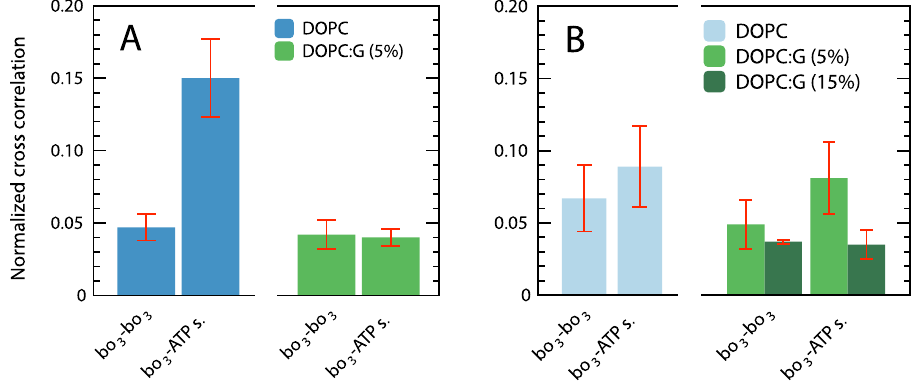
Figure 5. Summary of normalized cross correlation amplitudes measured with GUVs with co-reconstituted cyt. bo 3 and ATP synthase. ( A ) The normalized amplitudes were calculated from samples with cyt. bo 3 labeled with either ATTO 647 N or ATTO 594 ( bo 3 - bo 3 ), and cyt. bo 3 labeled with ATTO 647N and ATP-synthase labeled with ATTO 594 ( bo 3 -ATP s.). ( B ) Cyt. bo 3 was labeled with Abberior STAR 635. The lipid composition was either 99% DOPC (DOPC, blue) or 84–94% DOPC and 5–15% DOPG (DOPC:G, green), and in addition 1% DPPE functionalized with a biotinyl head group. Measurements were done at pH 7.4 in 10 mM HEPES supplemented with 10 mM NaCl and 100 mM glucose. Error bars represent standard deviation from measurements with five